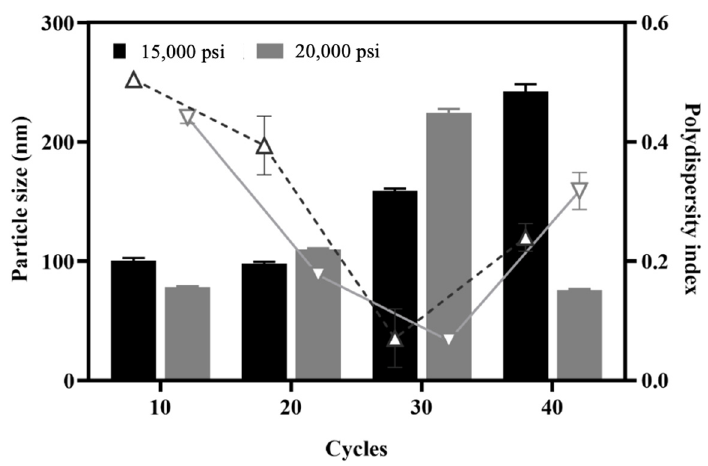
Figure 3. Effects of different pressures of high-pressure homogenization at different cycles on the particle size and size distribution. Column: particle size (nm); line: polydispersity index. Each point represents the mean ± SD. Error bars represent the standard deviation ( n = 3).